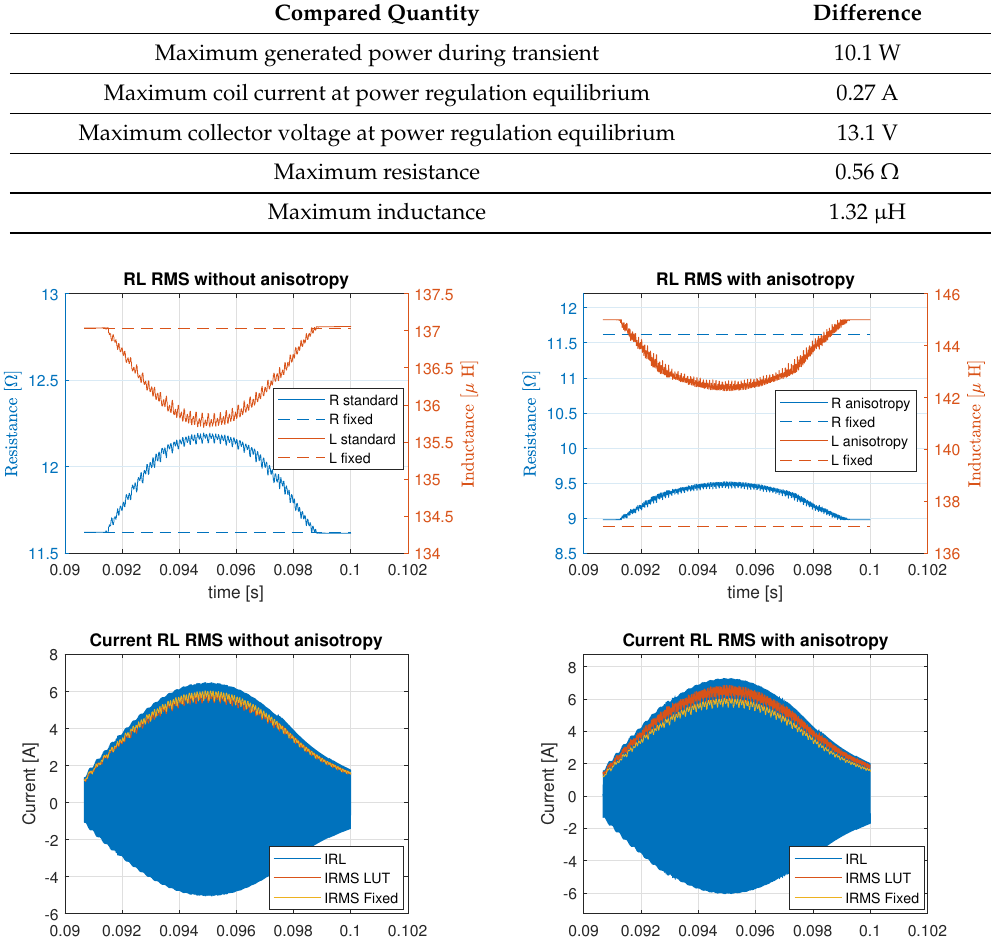
Table 2. Comparison between resulting quantities obtained with fixed impedance and waveform dependent impedance.